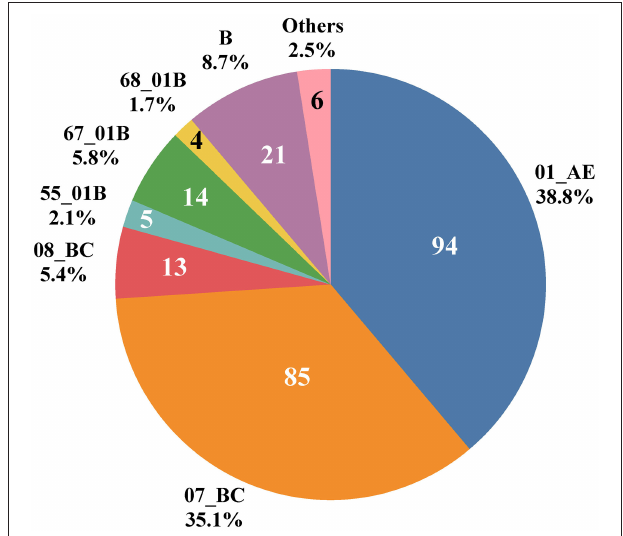
FIGURE 1 | HIV-1 genotypes distribution among 242 LLV patients in Jiangsu Province,